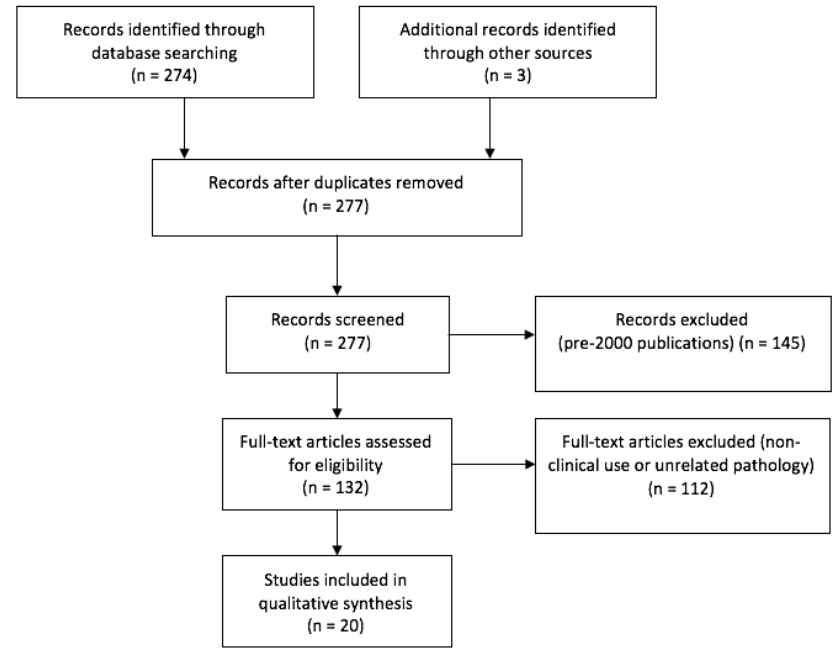
Figure 3. PRISMA flow